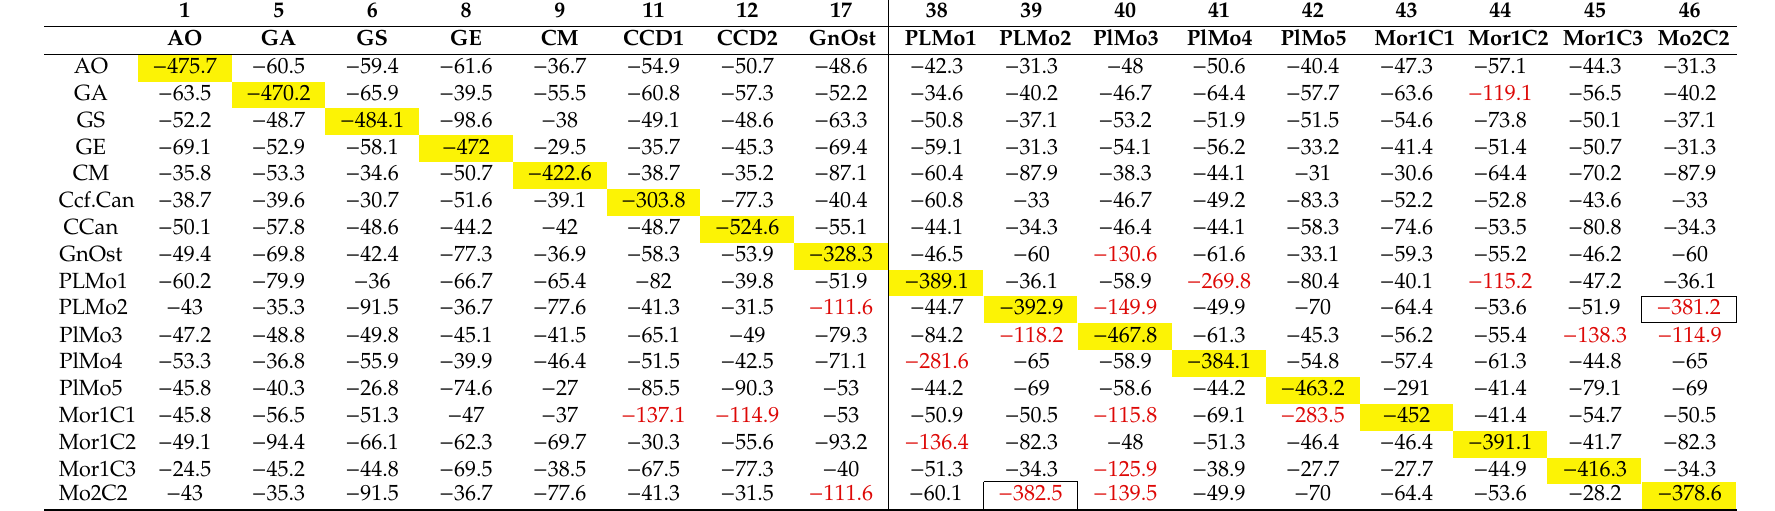
Table 2. Absolute values for energy required to denature a double stranded helix. The energy required for probe to target is shown on the yellow diagonal (100% match between probe and target). Those figures shown in red represent potential cross-reaction and those in red and boxed, the non-target signal is close to or greater than the target and are cross-reactions. Probes for the clades of Prorocentrum lima are to the right of the vertical